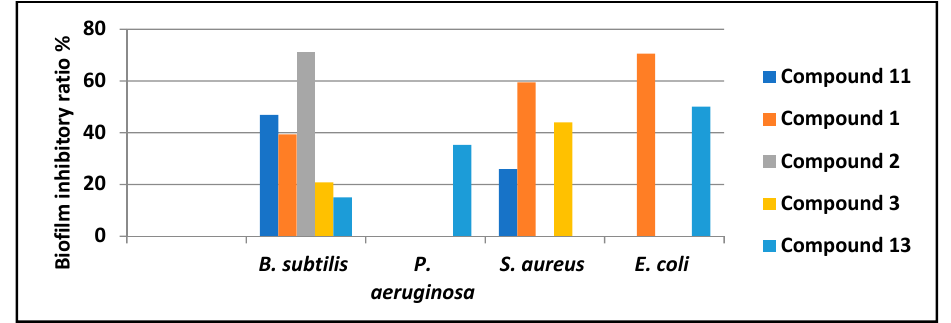
Figure 2. Biofilm inhibitory ratio of DCM Fraction purified metabolites. Compound numbers are the same as those presented in Tables 1 and 2.